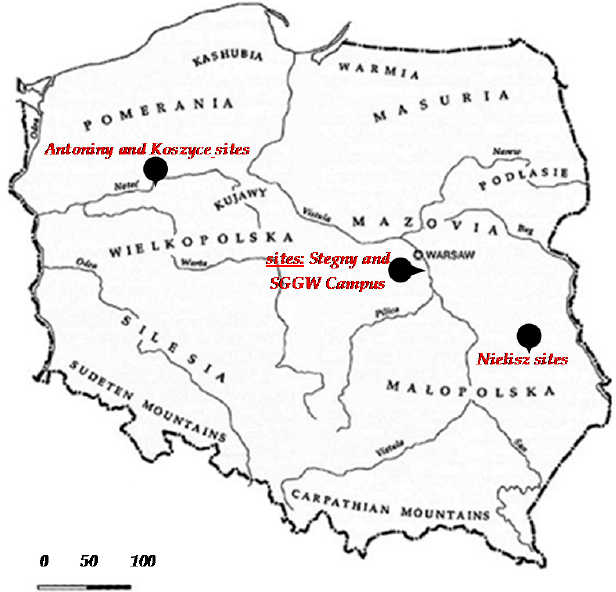
Figure 5. Location of test sites in the region of Poland.